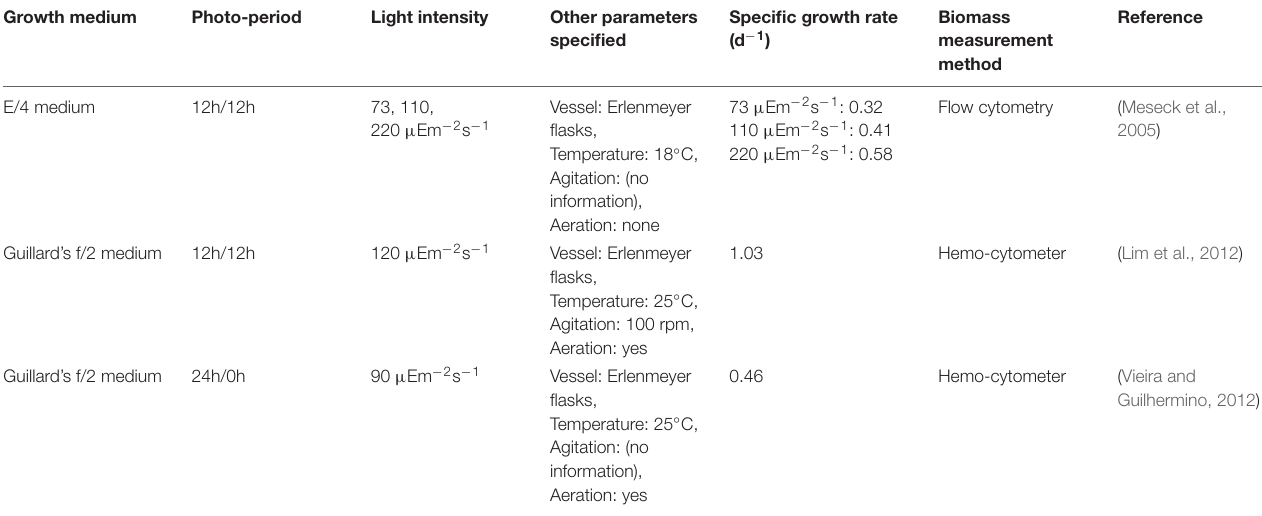
TABLE 3 | Growth rates of T. chuii observed in literature under various conditions. Growth